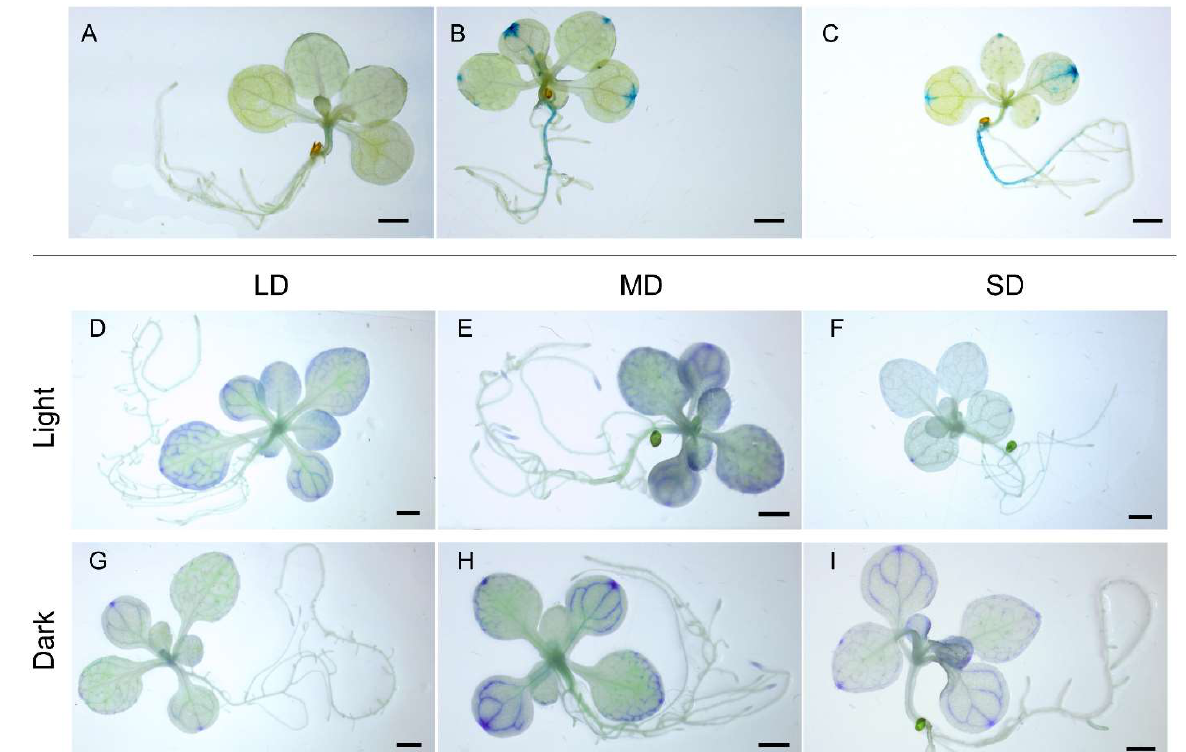
Figure 5. CsFLC1 in response to low temperature and daylength. ( A – C ) pCsFLC1::GUS response to low temperature (LT; 4 ◦ C): ( A ) before LT treatment; ( B ) after LT treatment for 3 h; ( C ) and after LT treatment for 4 h. ( D – F ) pCsFLC1::GUS staining in the light: ( D ) in plants under LDs; ( E ) in plants under MDs; and ( F ) in plants under SDs. ( G – I ) pCsFLC1::GUS staining in the dark: ( G ) in plants under LDs; ( H ) in plants under MDs; ( I ) and in plants under SDs. Bar = 1 cm; LD: long days; MD: medium days; SD: short days.